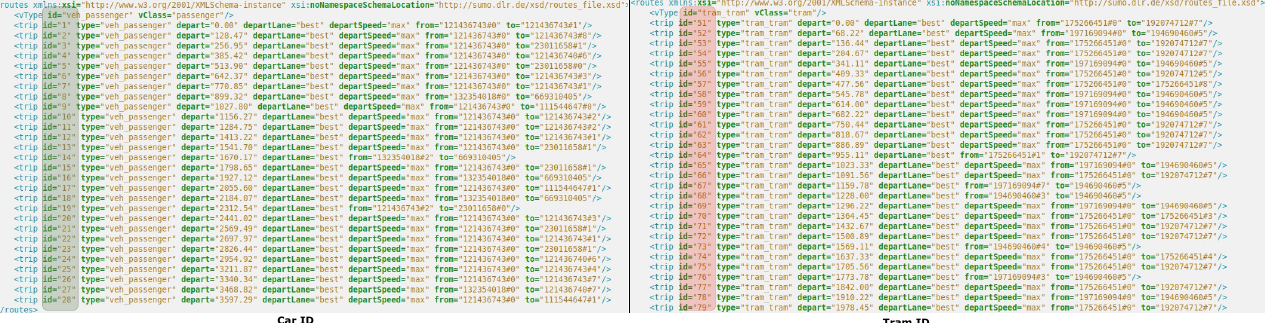
Figure 44. Change IDs of